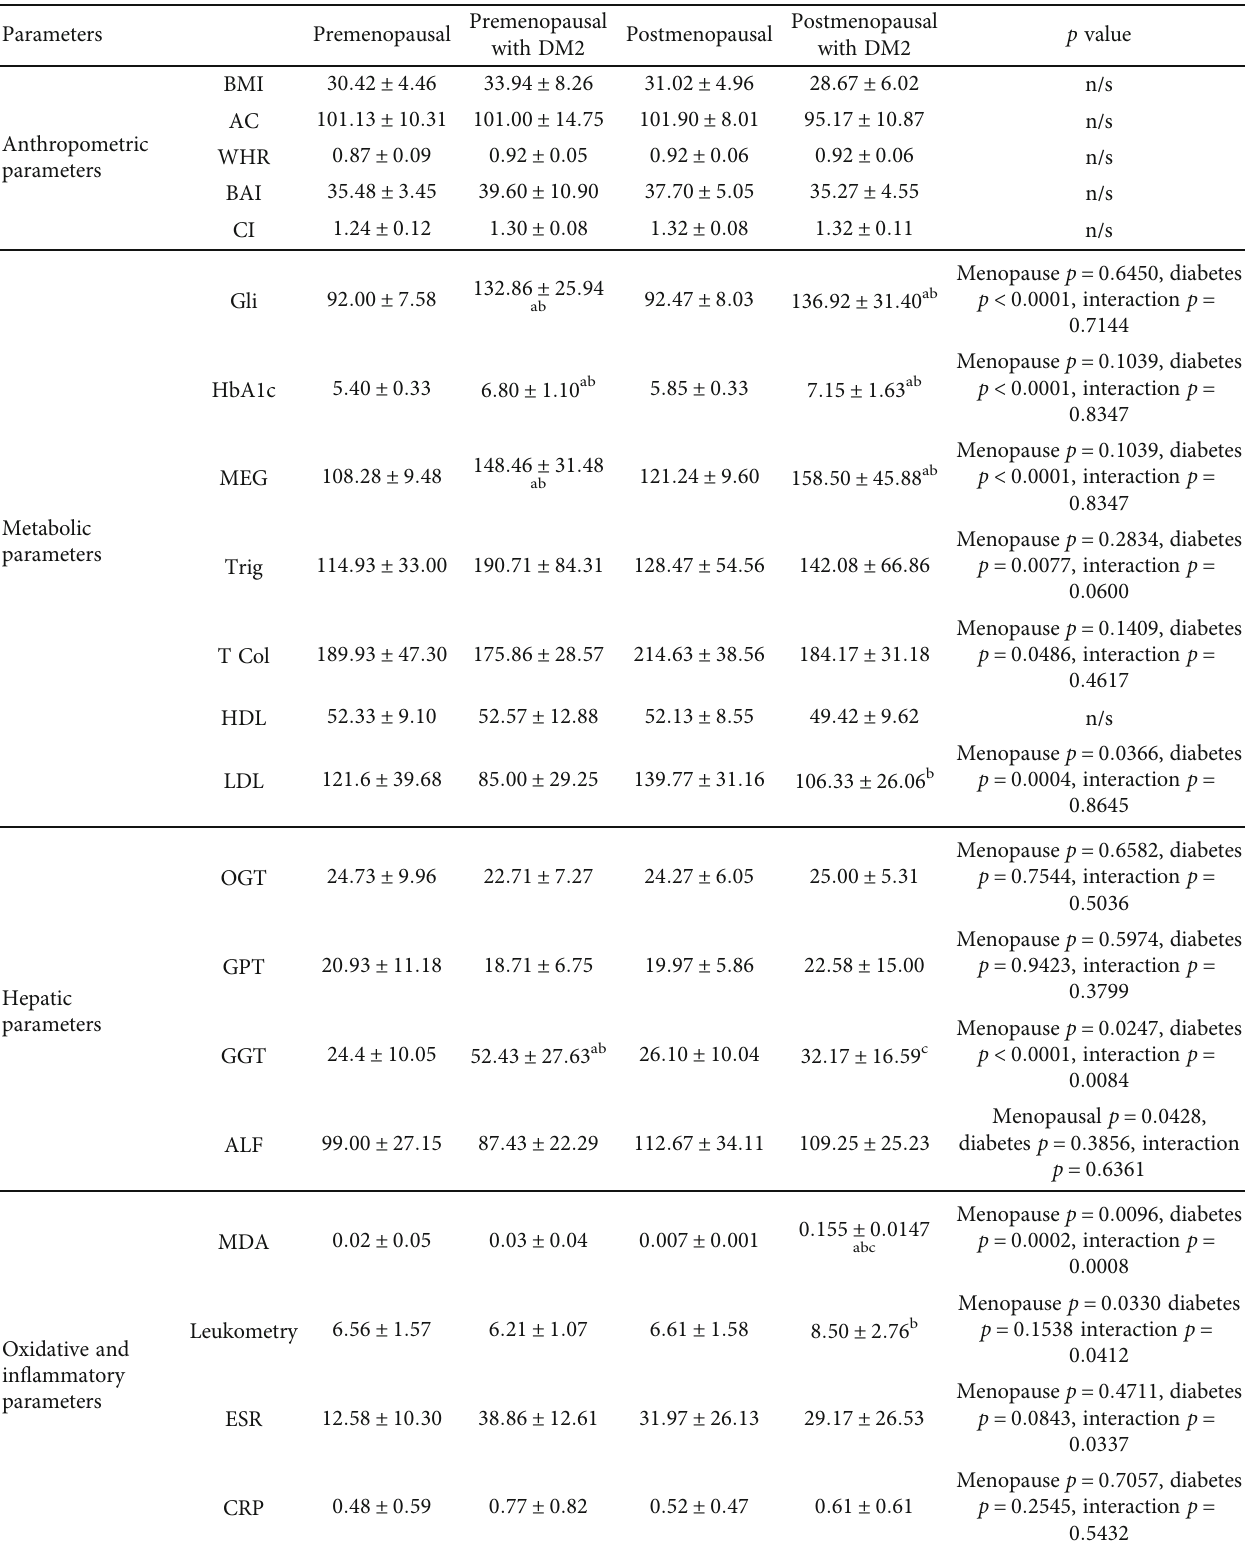
Table 1: Anthropometric, metabolic, oxidative, in fl ammatory, and hepatic parameters from pre- and postmenopausal women, with or without DM2